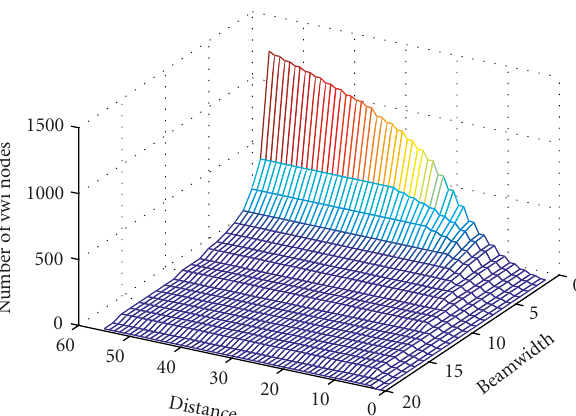
Figure 6: The dependence of the number of vwi nodes on the dis- tance from the source and the